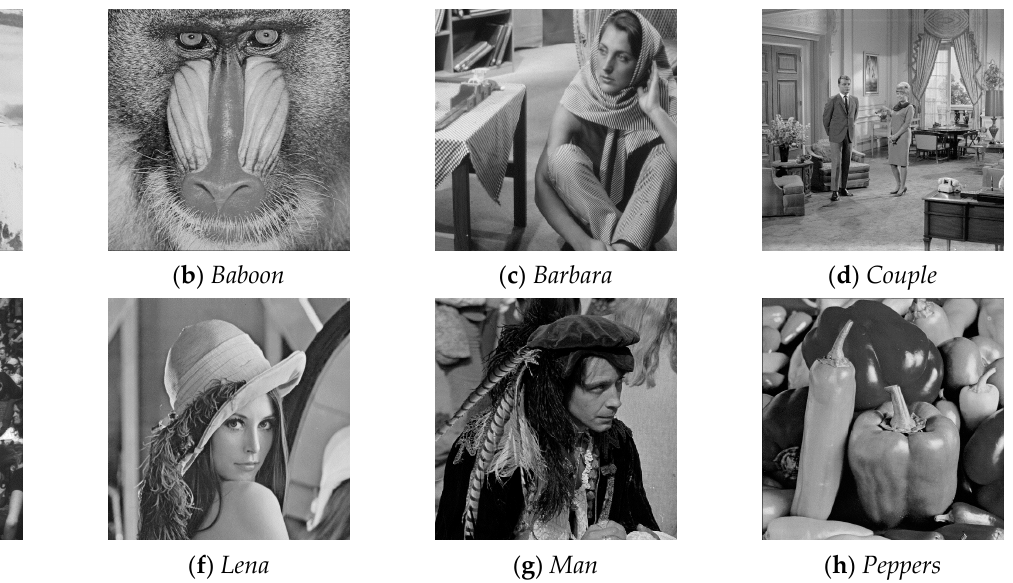
Figure 5. The eight test images.